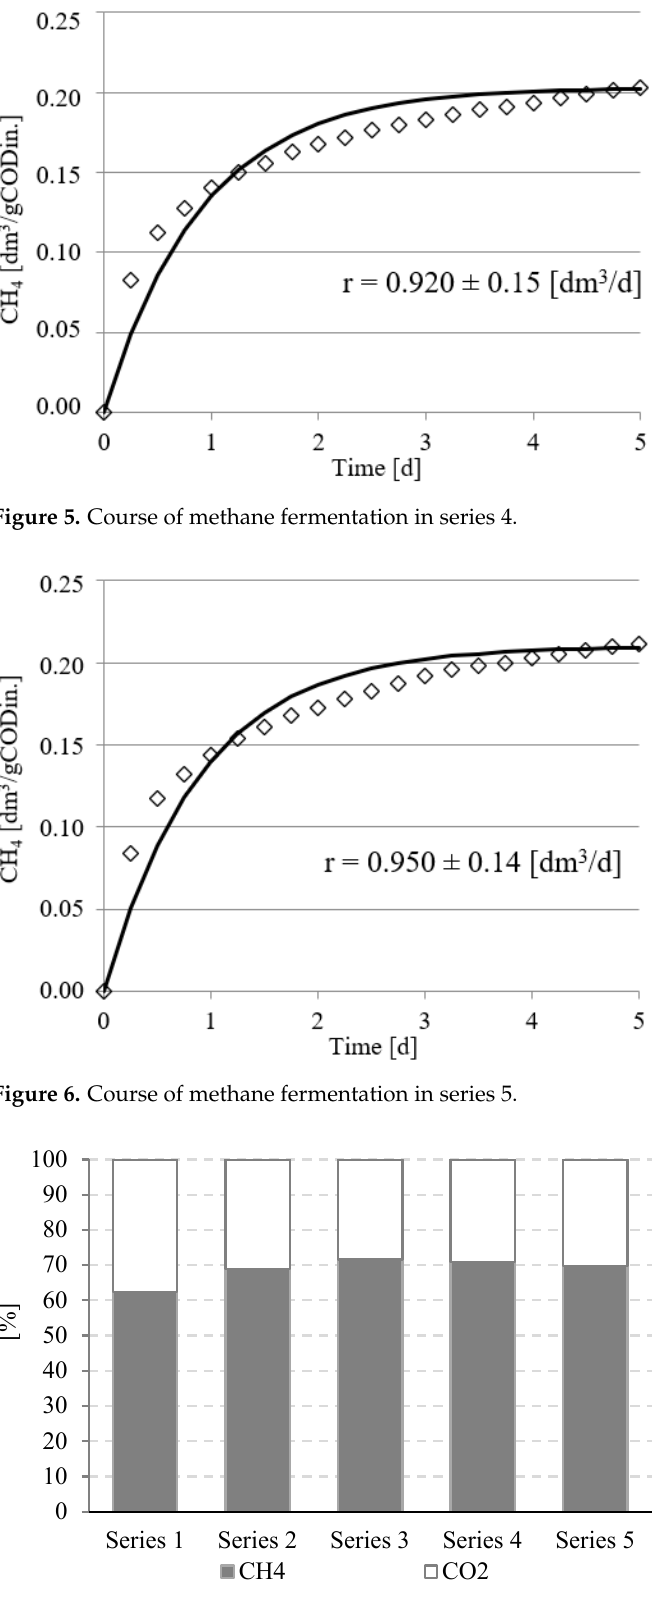
Figure 7. Methane content of biogas in particular experimental series.